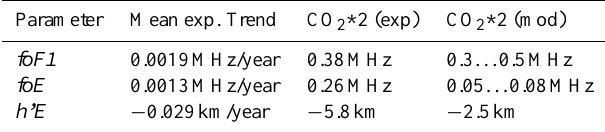
Table 2. The experimental trends of different ionospheric parame- ters, their extrapolation to CO 2 *2 conditions, and, for direct com- parison, the model results of Rishbeth (1990) and Rishbeth and Roble